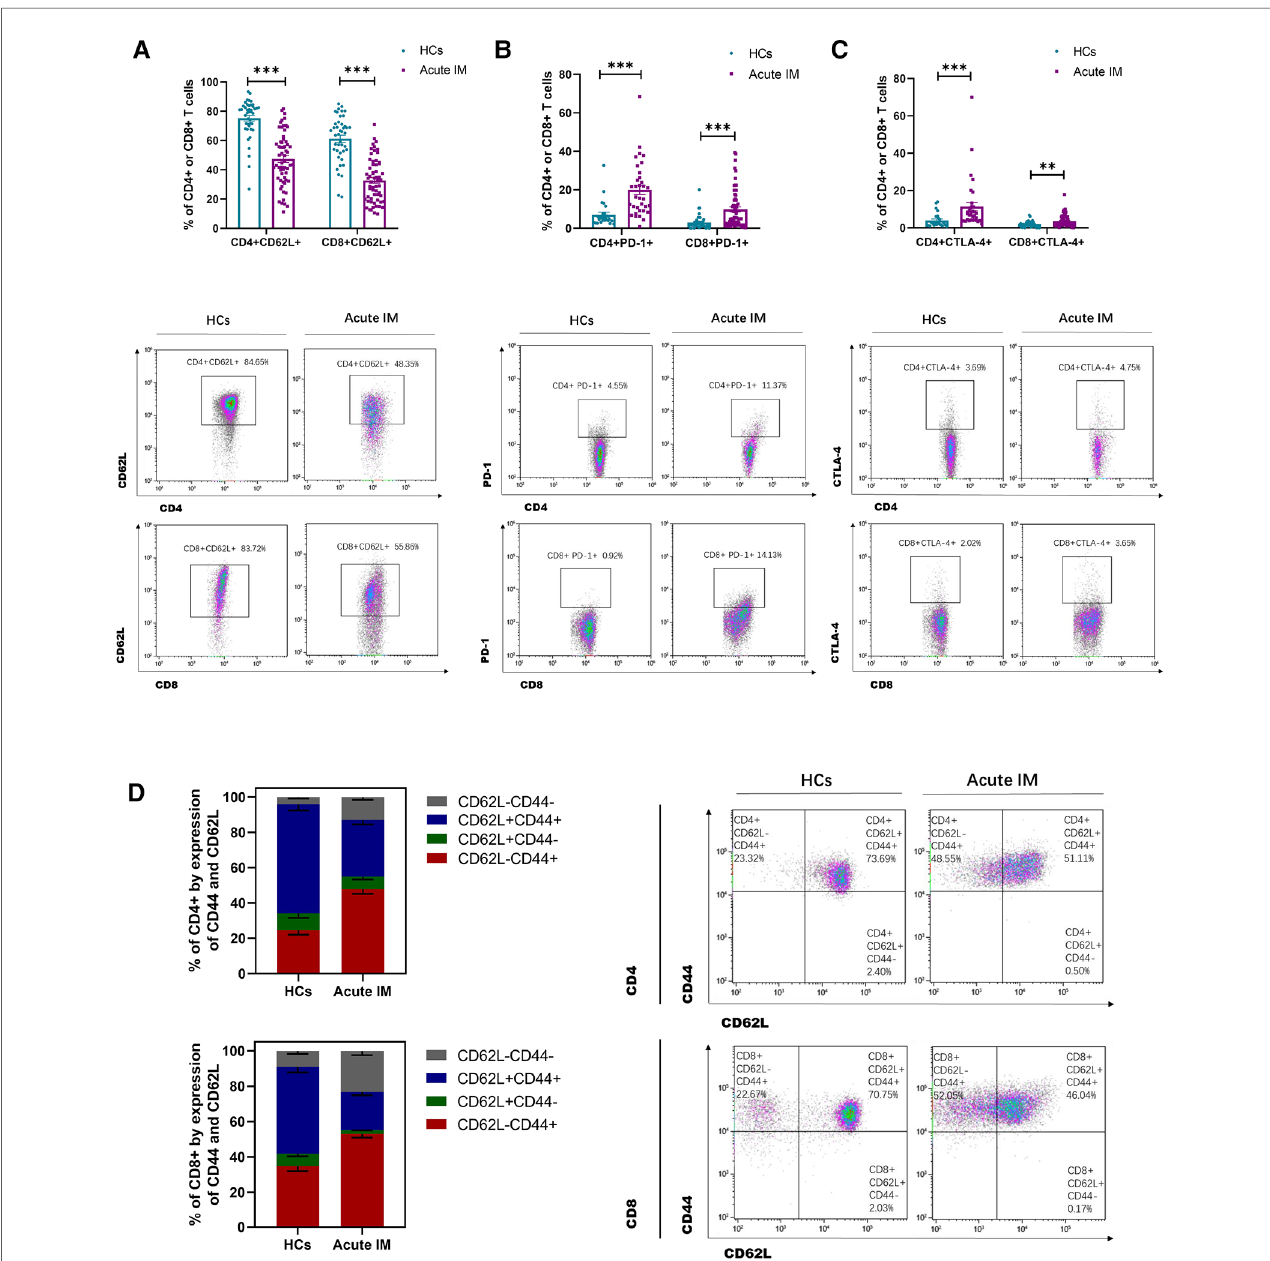
FIGURE 2 Analysis of T cell immunophenotype characteristics in pediatric patients with IM. The activation of T cells was analyzed by fl ow cytometry, as indicated by active and inhibitory molecules. The expression of ( A ) CD62L, ( B ) PD-1, and ( C ) CTLA-4 on CD4+ and CD8+ T cells in IM patients and HCs. ( D ) The frequencies of the differentiation subsets of CD8+ T cells and CD4+ T cells in the peripheral blood are demonstrated by the CD44 and CD62L expression. Data are expressed as the mean±SD. ** P <0.01, *** P